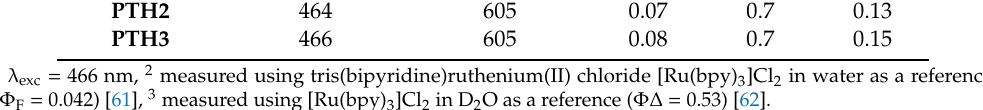
Table 2. Optical characteristics of phosphonium-based polythiophene CPEs in water.